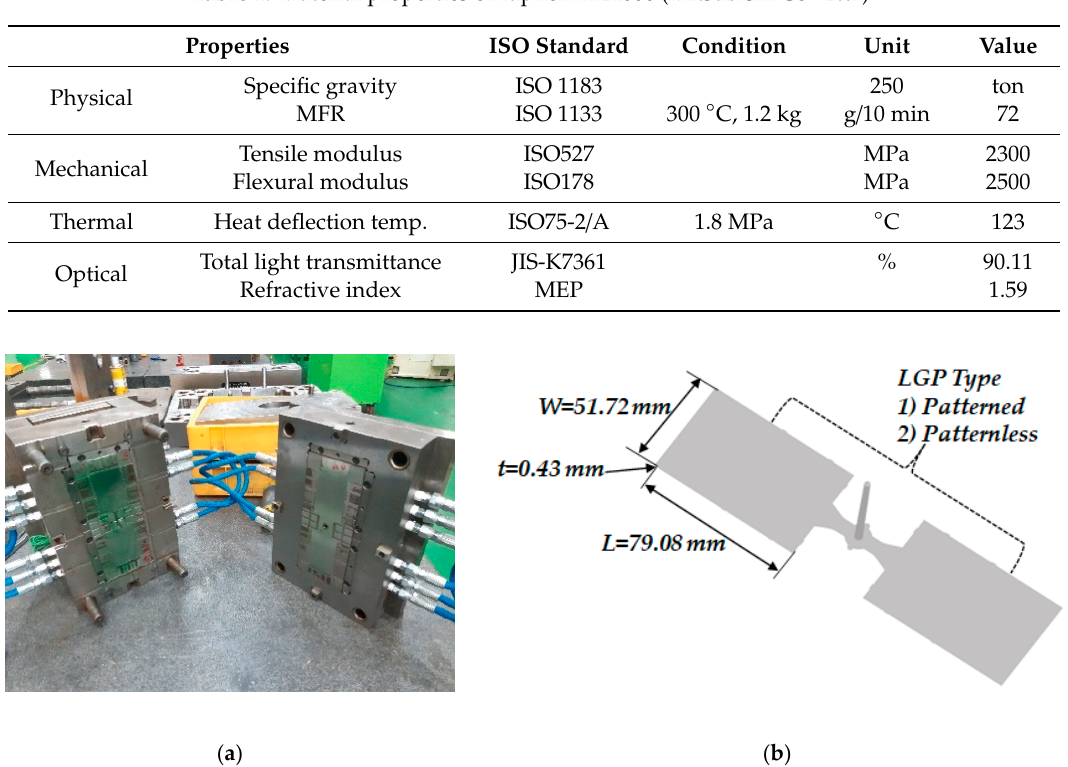
Figure 3. ( a ) Depiction of the mold; ( b ) light guide plate (LGP) dimensions.